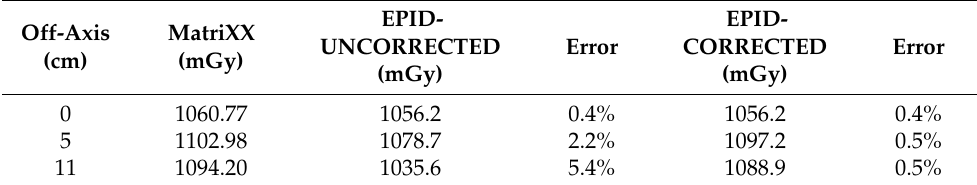
Table 2. The error between the dose value calculated using the central axis conversion coefficient and the measured dose value at different off-axis